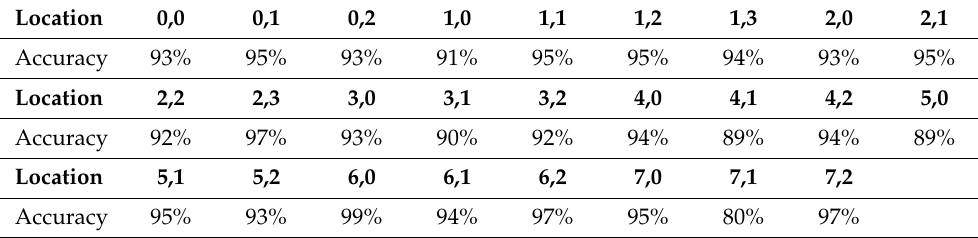
Table 11. Estimation accuracy of TAG location in real deployment after applying the post- processing